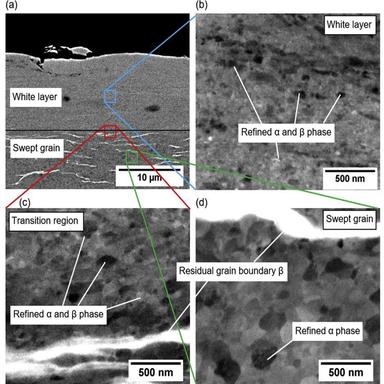
Cross-sectional backscattered electron SEM images of un-etched sample 9 sectioned perpendicular to the feed direction showing the white layer and the swept grain region at 10,000 x (a), a higher magnification (160,000 x) image of the white layer (b), the transition region between white layer and swept grain (c) and the swept grain region (d).